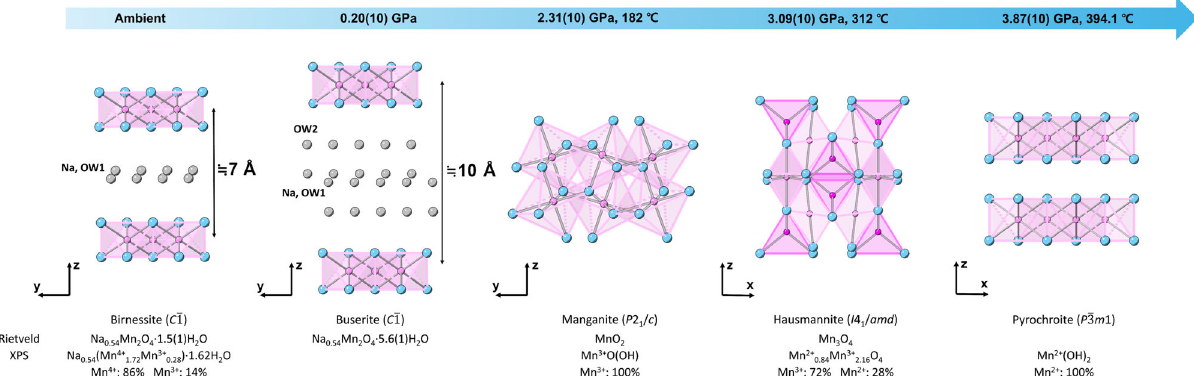
Fig. 3 Successive transformations from birnessite to buserite, manganite, hausmannite, and pyrochroite along the simulated cold subduction geotherm conditions. Pink and light-blue spheres represent manganese and oxygen atoms, respectively. Gray spheres represent statistically disordered water molecules and sodium cations.